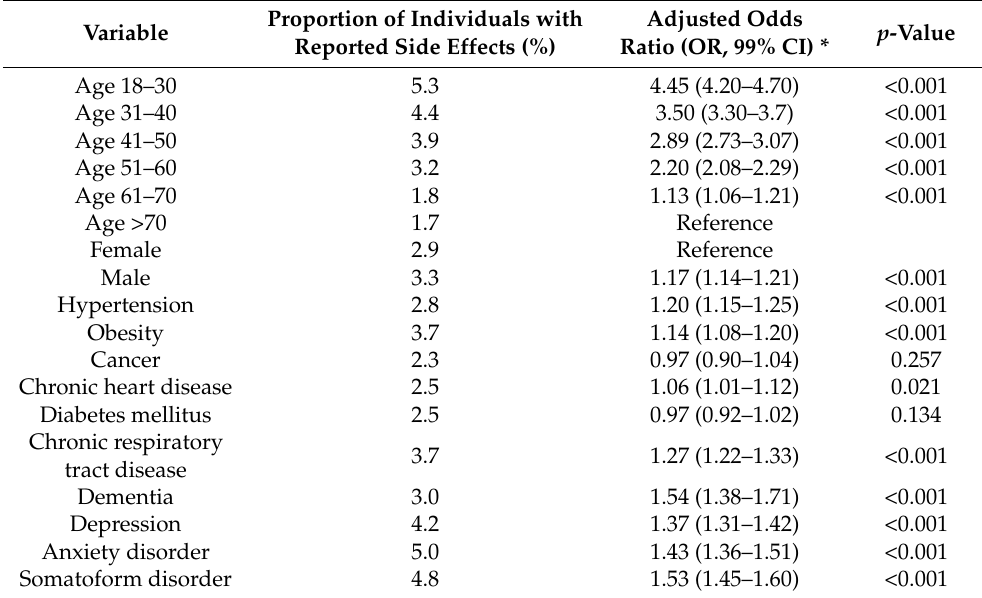
Table 2. Association between predefined variables and side effects reported following SARS-CoV-2 vaccination in general practices in Germany (Multivariate logistic regression